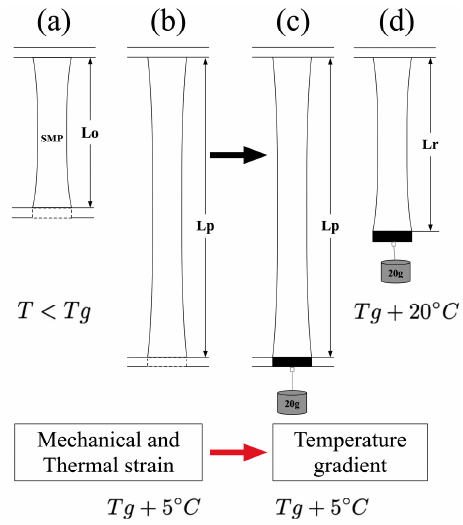
Figure 2. Schematic showing the programming and shape recovery procedure of a Shape Memory Polymer ribbon, where ( a ) shows the original sample ( b ) and ( c ) the sample while and after shape programming, respectively and ( d ) the recovered sample.